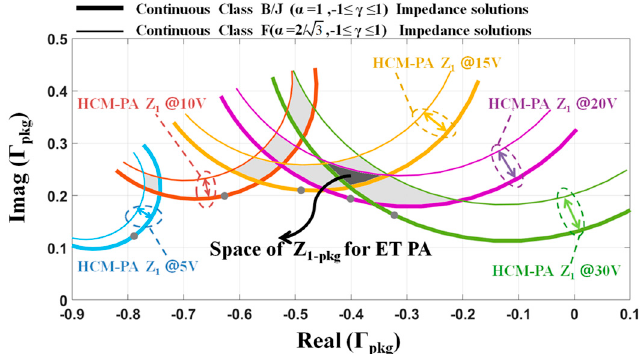
Figure 3. Fundamental impedance solutions of hybrid continuous modes power amplifiers (hybrid continuous modes (HCM) PAs) at the package plane.